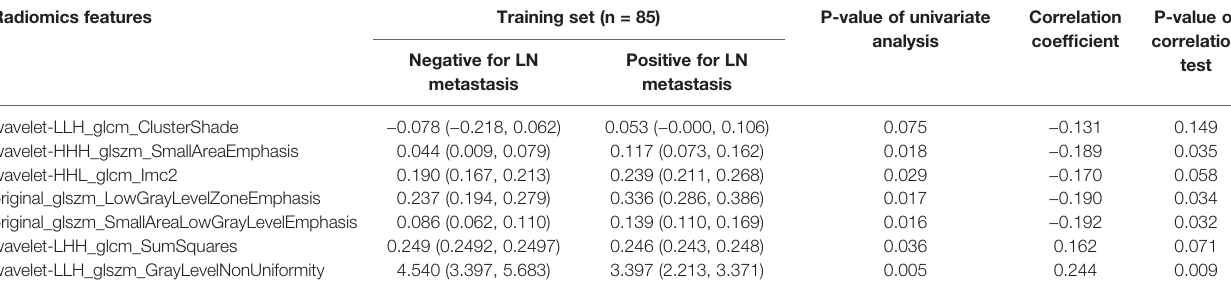
TABLE 2 | Univariate analysis and correlation test for radiomics features used in the LR model for the training set. Radiomics